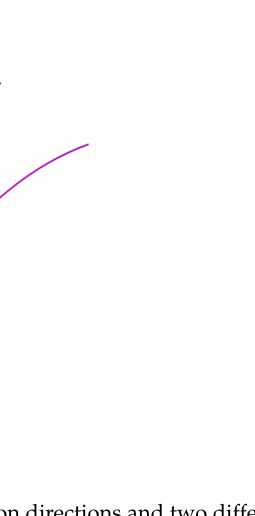
Figure 2. Two different injection directions and two different increments d Λ 1 and d Λ 2 of the distance along the injection line, both corresponding to the same increment of the effective radius d ρ .